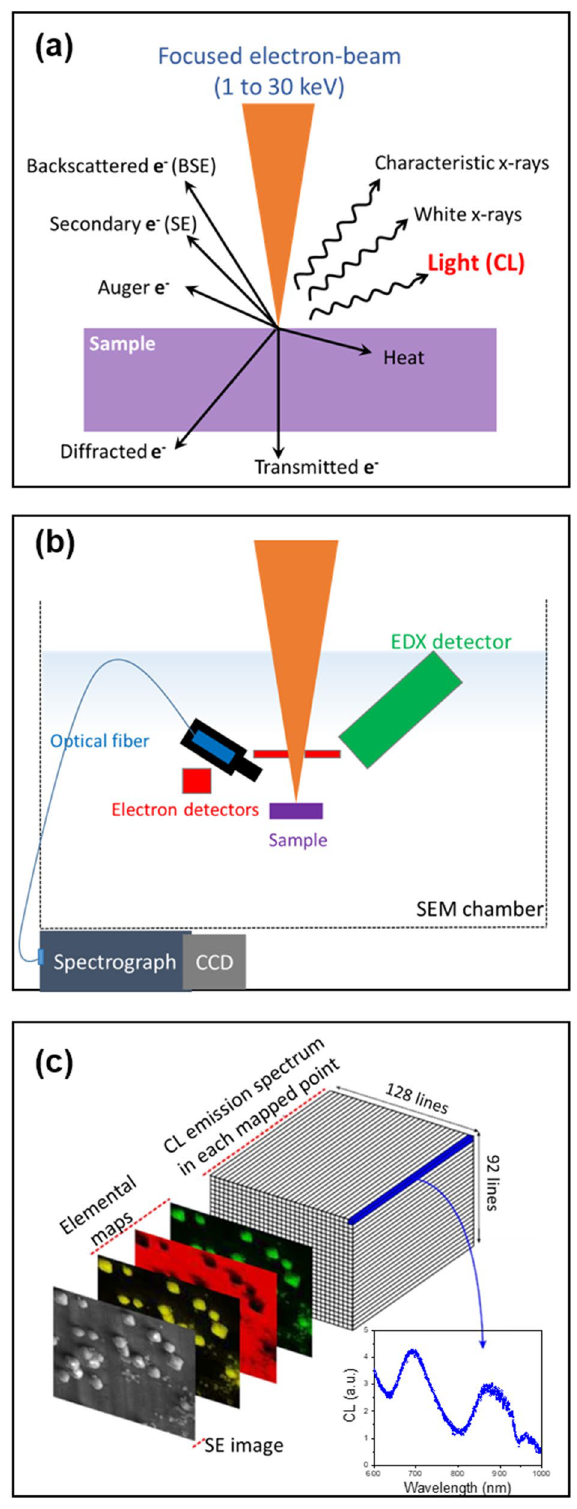
Figure 7. Schematic representation of the experimental aspects of cathodoluminescence (CL) microscopy. ( a ) Interaction of electron beam with the sample and the resulting radiations. ( b ) Sketch of the main components of the scanning electron microscope (SEM) used for the CL mapping. ( c ) Examples of data generated: the secondary electrons (SE) image, elemental maps, CL maps, and spectra. These images were created using Mircosoft PowerPoint (Version: 2013, Url: https ://www.micro